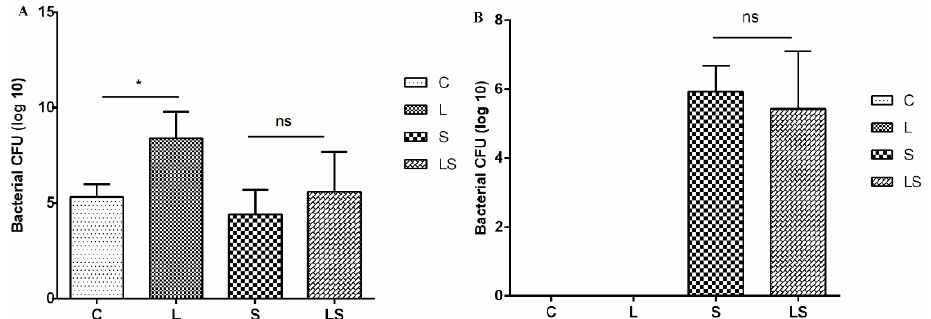
Figure 3. Bacterial count of chicken cecum. ( A ) indicates chicken cecum lactic acid bacteria count, and ( B ) indicates Salmonella count in chicken cecum. C = control group, L = L. reuteri S5 group, S = S. enteritidis infection group and LS = L. reteri S5 + S. enteritidis group. ns indicates that the compar- ison between the two groups is not significant, * means p < 0.05.